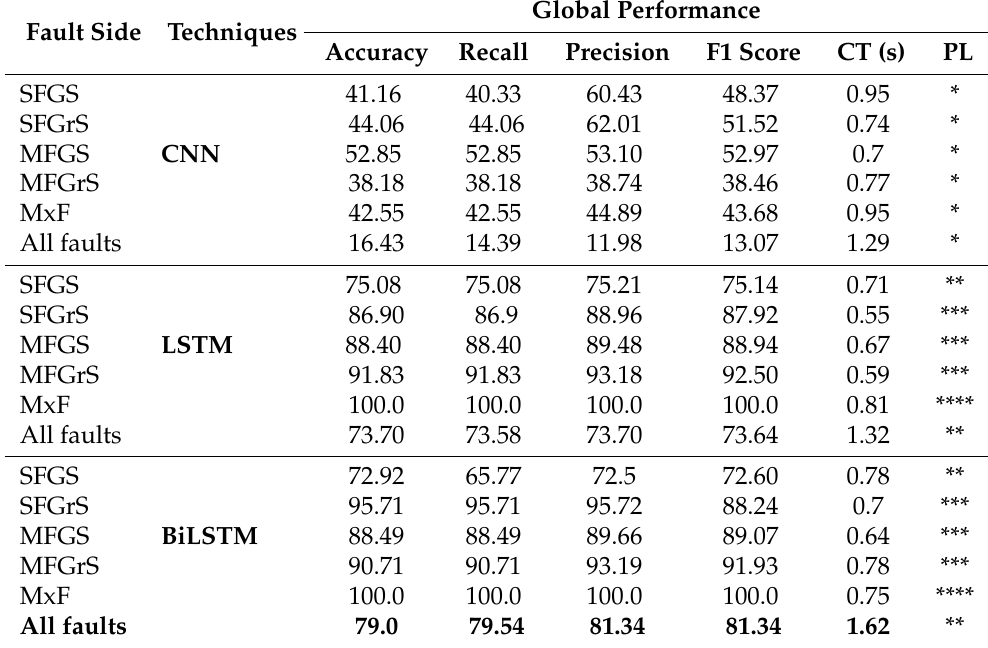
Table 7. Performance comparison of deep learning